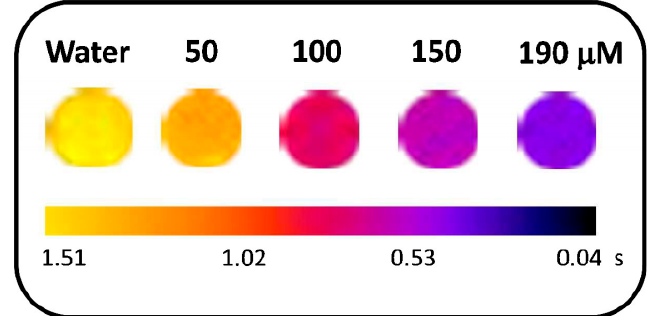
Figure 17. T 2 map associated with PAA-coated Ni nanowires, obtained at 3 T and at 37 °C .